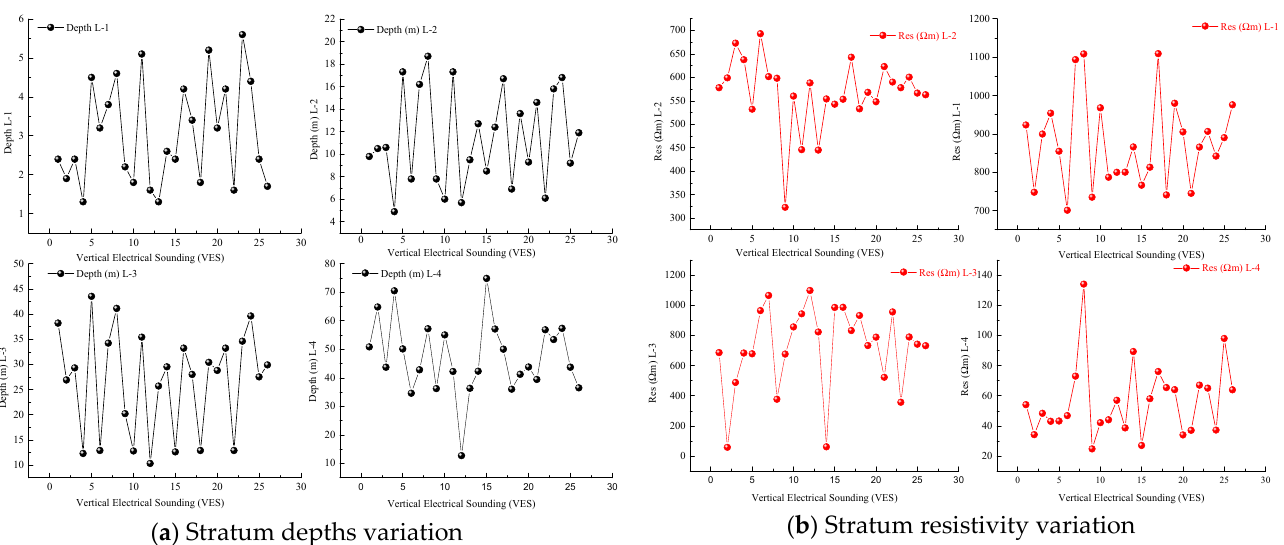
Figure 10. VES data interpretation result-based partial curve matching (PCM) along 26 VES stations: ( a ) hydrologic layers depth variation; ( b ) hydrologic layers resistivity variation.